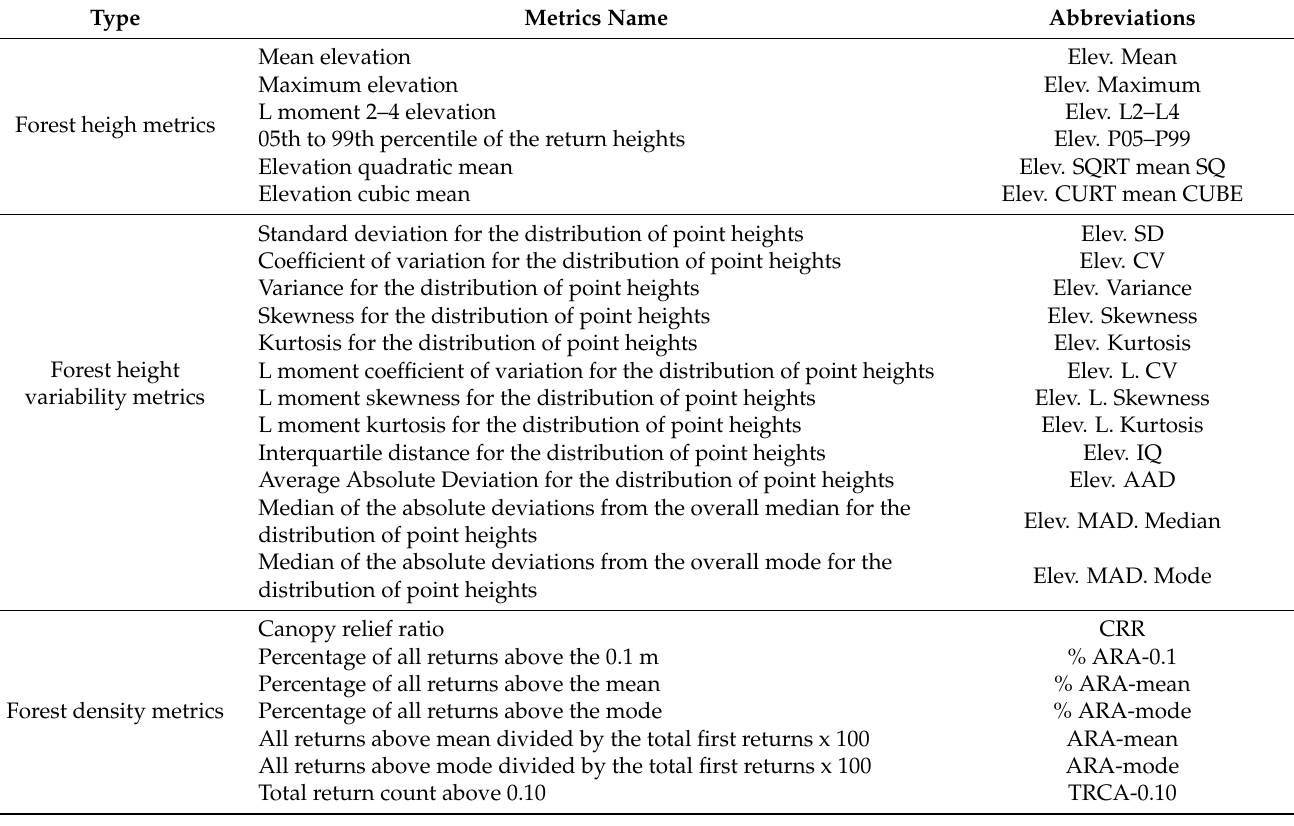
Table 3. Summary of the computed metrics including the